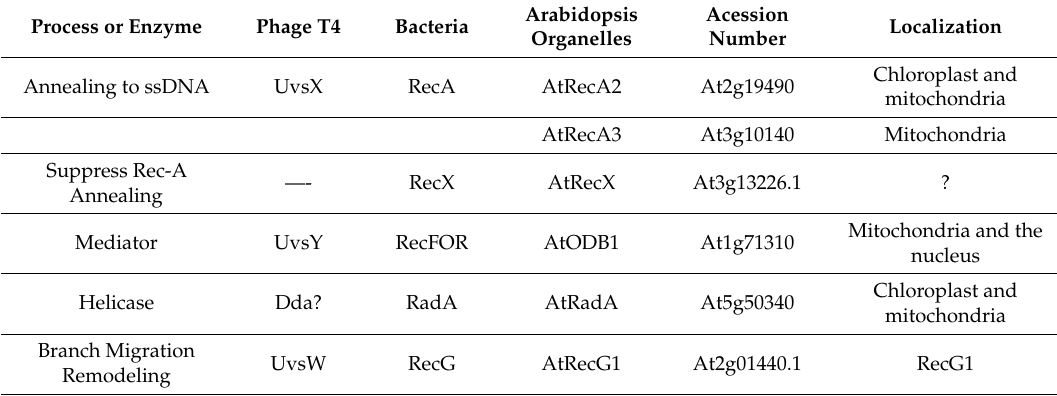
Table 2. Plant mitochondrial proteins related to bacteriophage T4 recombination-dependent replication